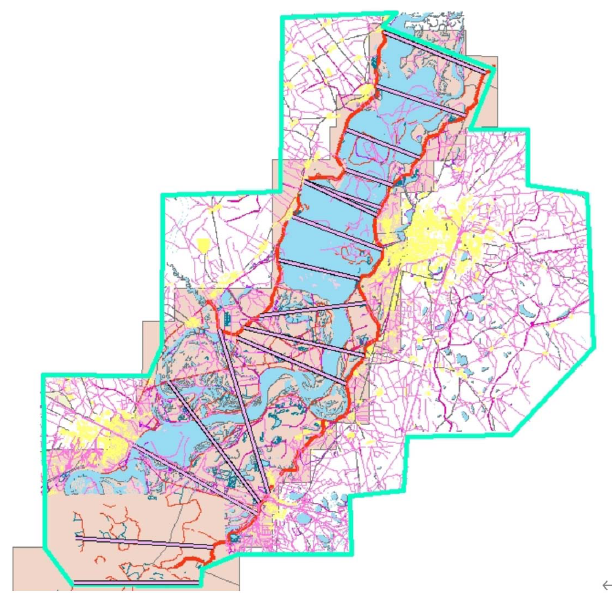
Figure 7. Simulation area of two-dimensional model in Qiqihar.